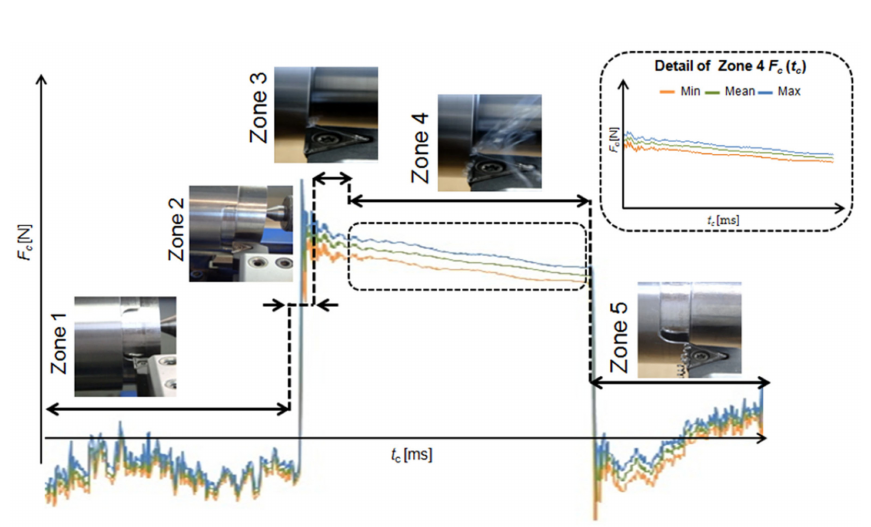
Figure 3. Di ff erent zones along the main cutting force dynamic signal F c ( t c ).